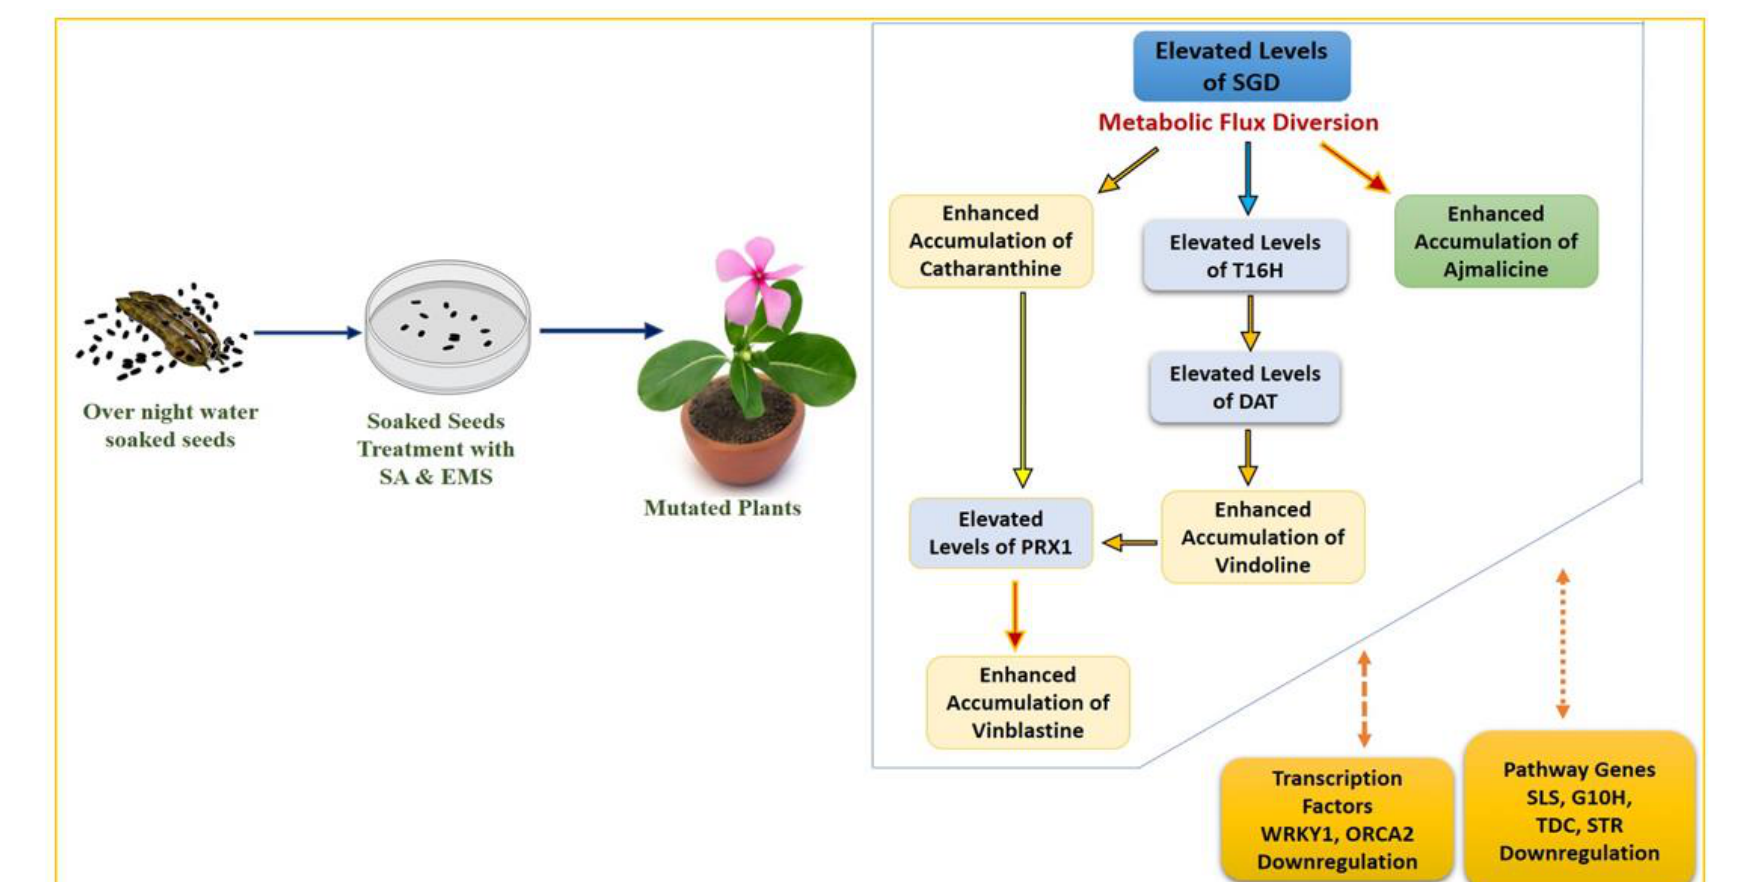
Figure 9. Mutagenesis’ possible correlation with MIA content and gene expression in SA- and EMS-mutated plants.